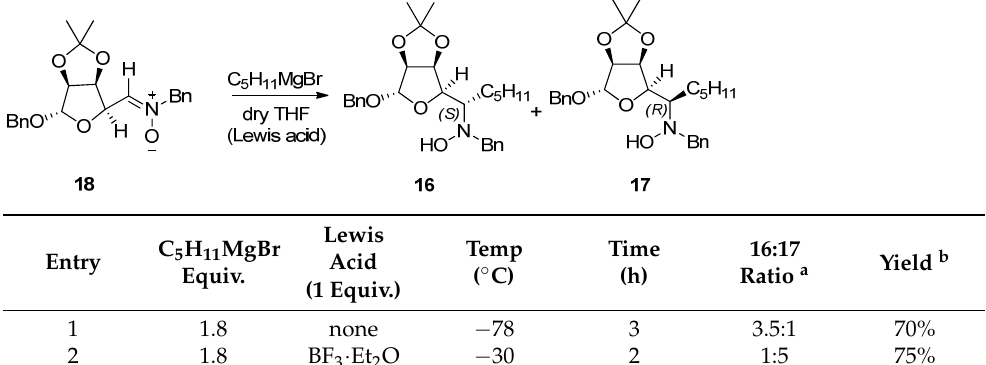
Table 1. Addition of pentyl magnesium bromide to nitrone 18 .